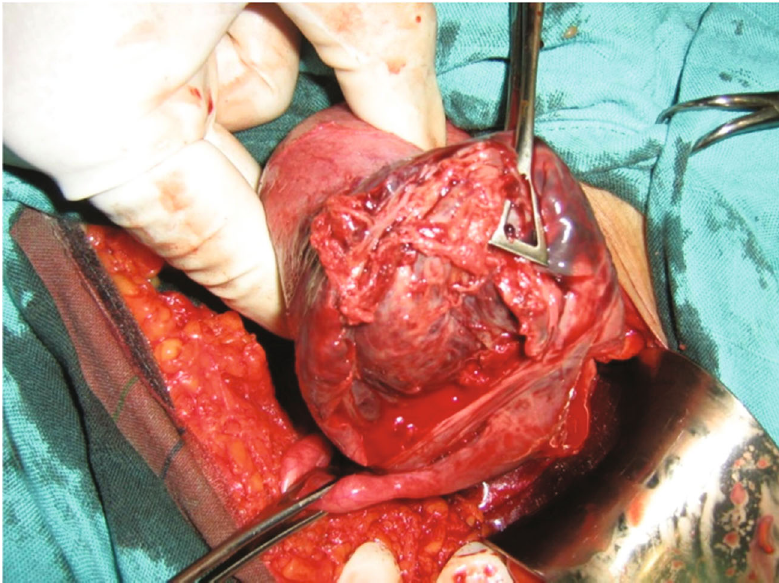
Figure 3: Ruptured rudimentary horn with placenta and fallopian tube ipsilateral.